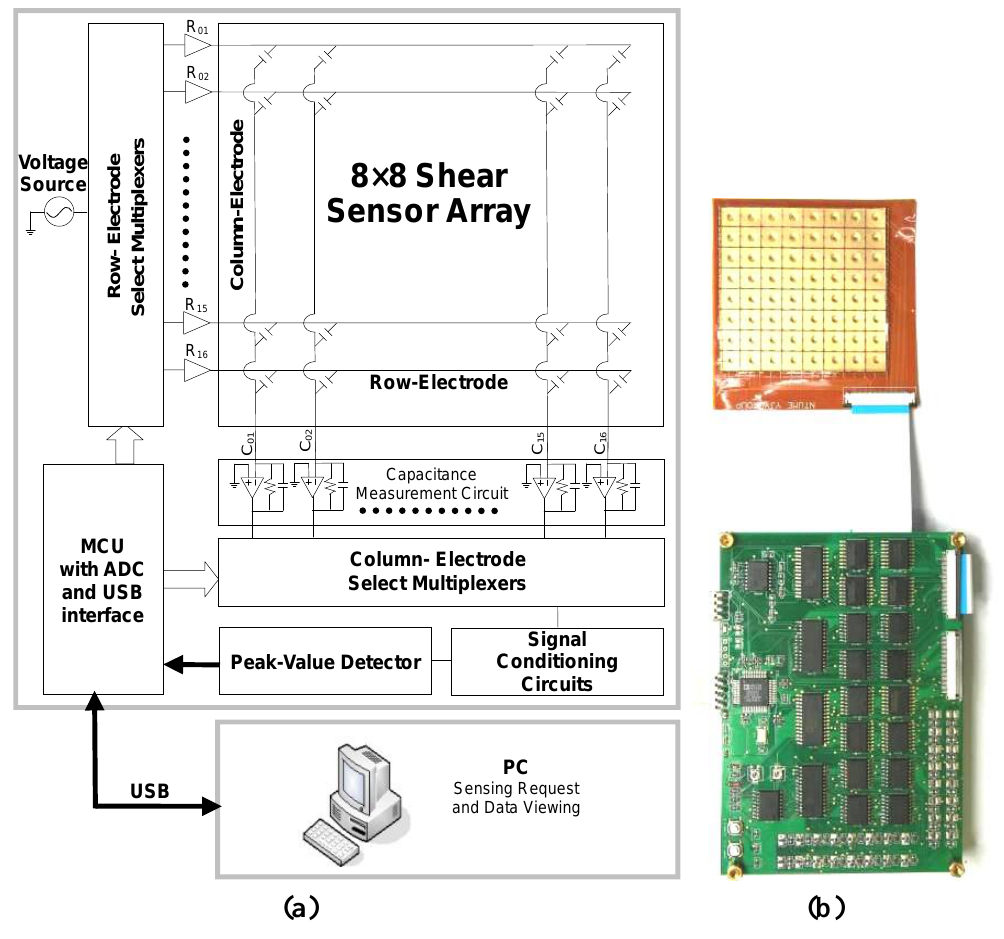
Figure 10. (a) The schematic of the sensing-array system with scanning circuitry. (b) The picture of the sensing-array with scanning